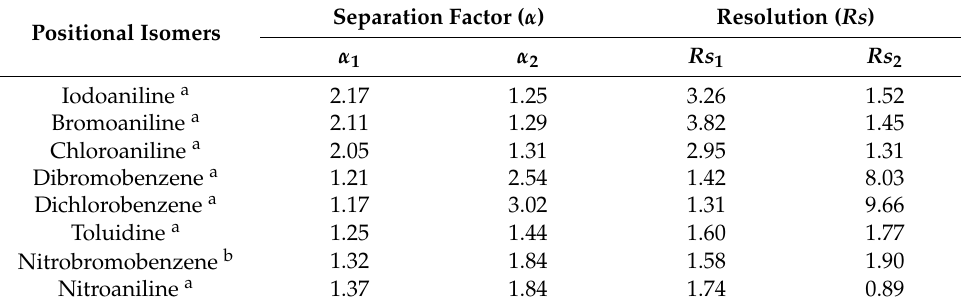
Table 2. Separation of positional isomers on the chiral POC column. Positional Isomers